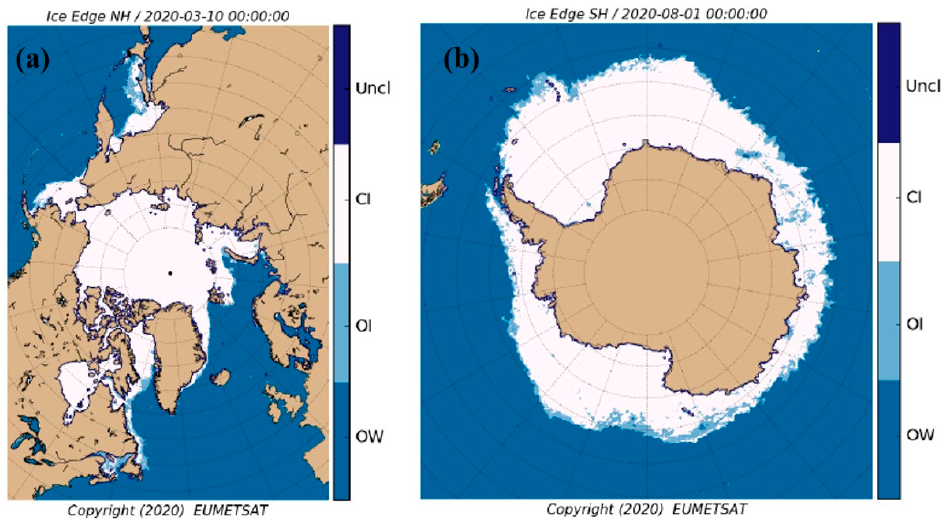
Figure 2. OSI SAF sea ice edge product in the 8 April 2020 from ( a ) Arctic and ( b ) Antarctic, respectively. Figures are accessed from https://osisaf-hl.met.no/quicklooks-1prod (accessed on 18 November 2021).